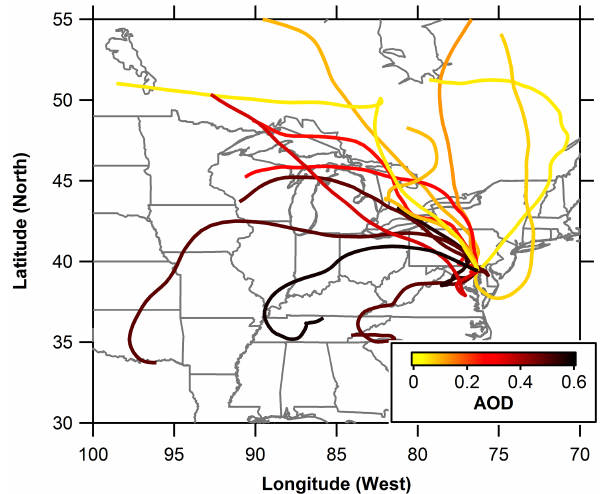
Figure 6. 72h back trajectories based on HYSPLIT for the first circuit of each flight at site 5 at an altitude of 1km colored by the average AOD measured during that